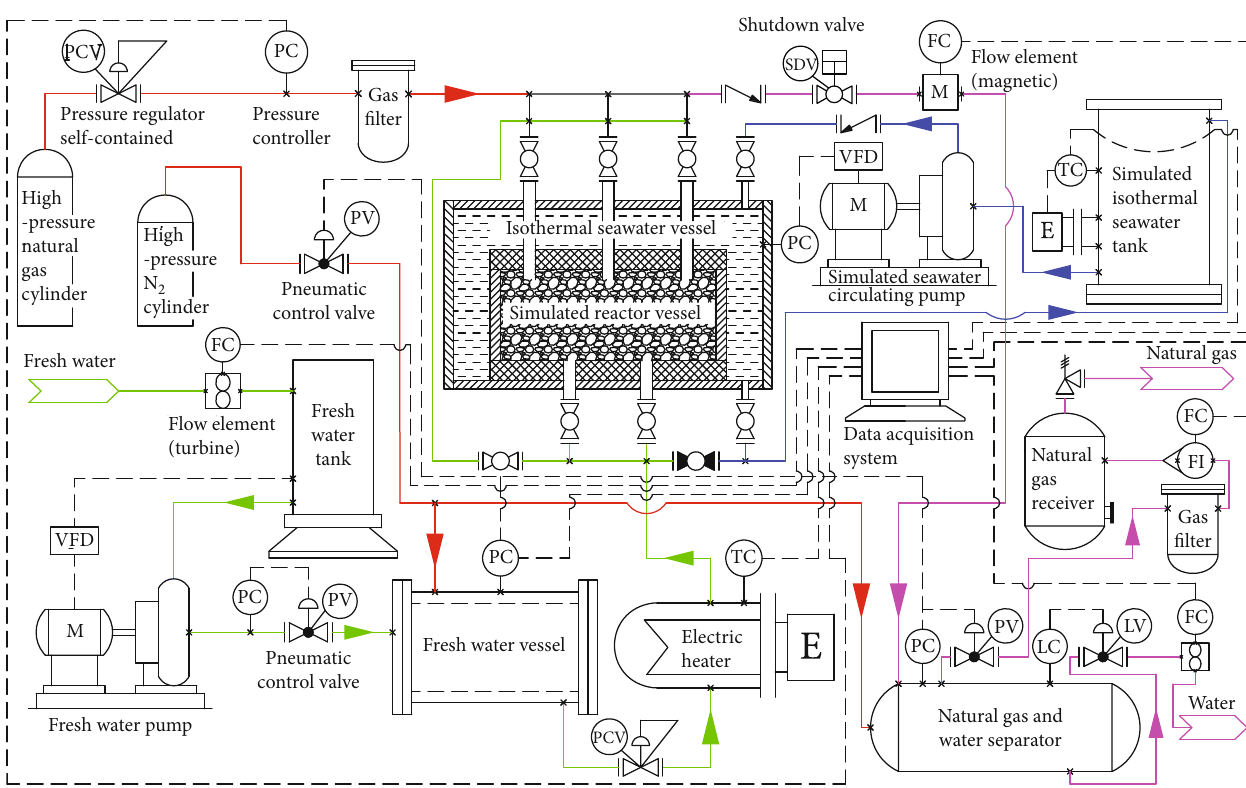
Figure 1: Process fl ow diagram of the o ff shore NGH formation and dissociation system by